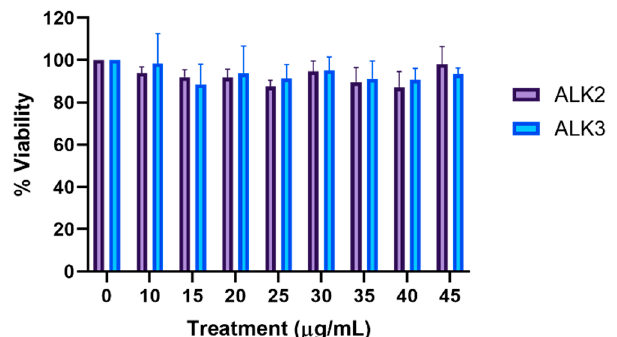
Figure 9. Peptides were prepared using film dehydration and rehydrated in water. Peptide assemblies were incubated with cells at varying concentrations for 48 h, followed by viability analysis via MTS assay. Untreated cells were treated as 100% viable. Results are presented as mean ± SEM (N =